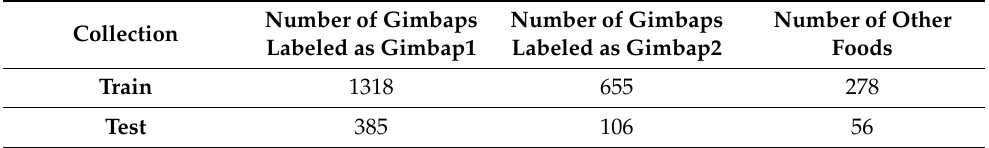
Table 1. Dataset statistics after the annotation process.